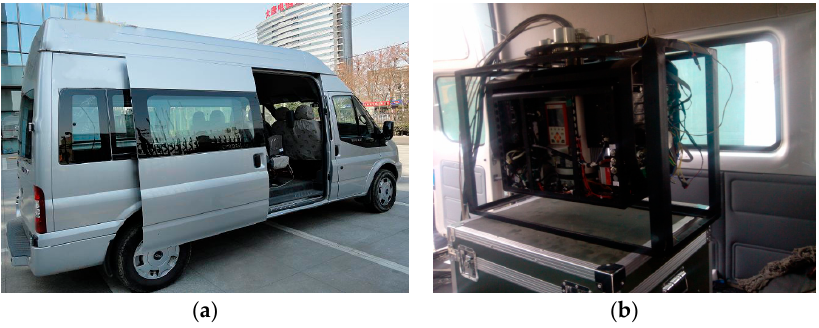
Figure 16. Pictures of the experimental equipment in dynamic experiments: ( a ) moving vehicle; ( b ) two-axis ISP inside the vehicle.